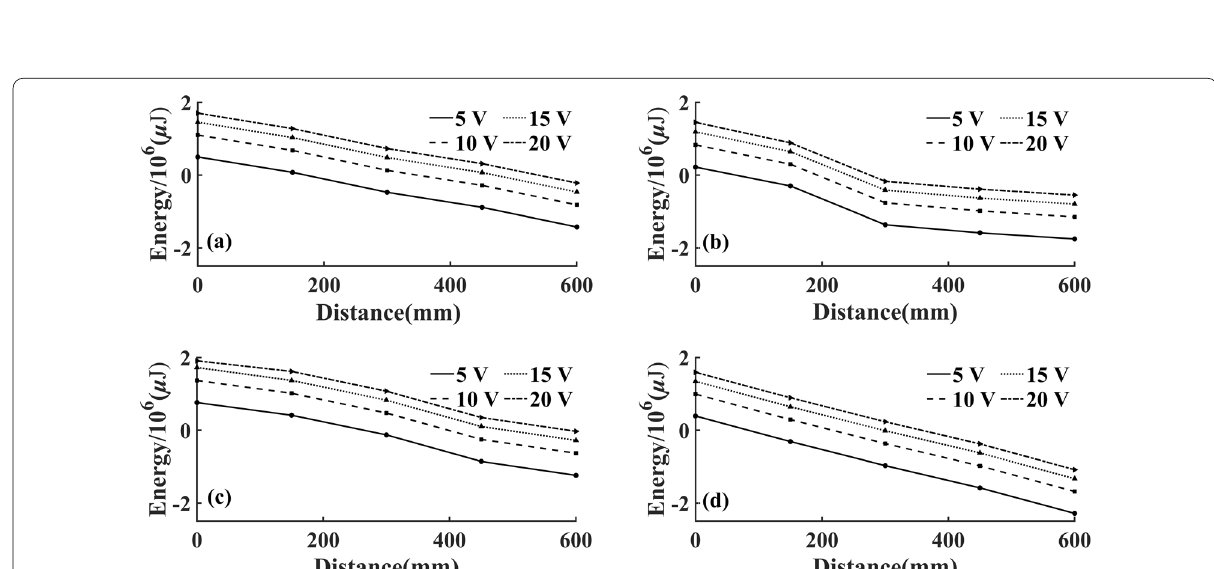
Fig. 6 Energy attenuation curve of AE longitudinal